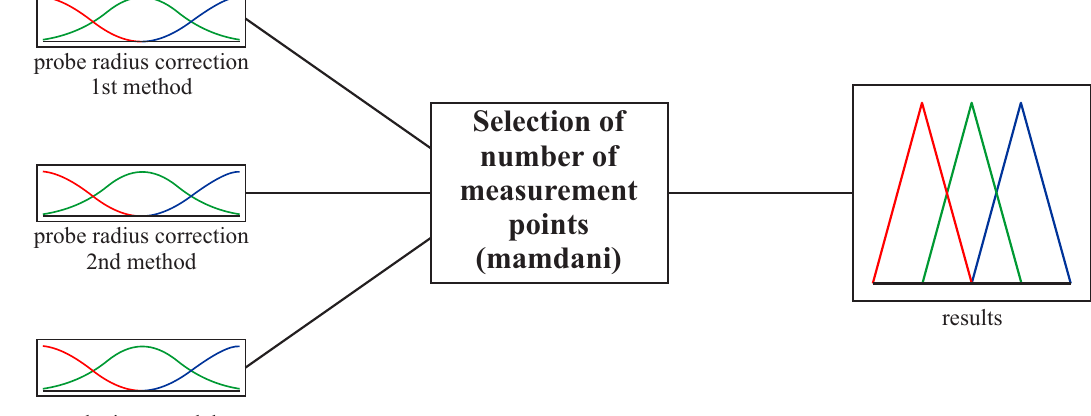
Figure 8. The structure of the second part of the expert system.